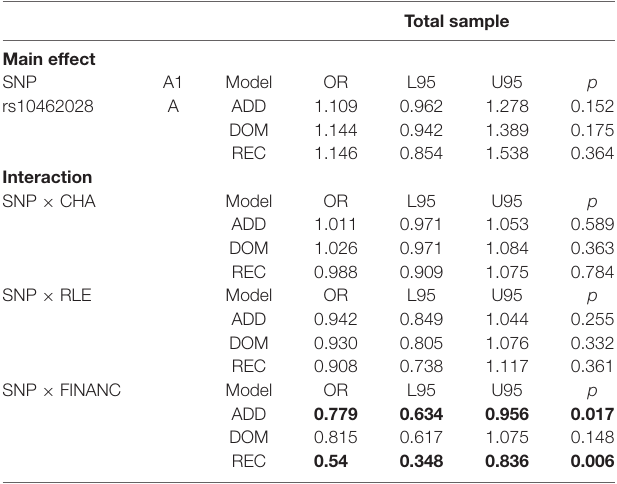
TABLE 2 | Statistical results of main genetic effects and interaction effects between rs10462028 and stress factors on migraineID in the total